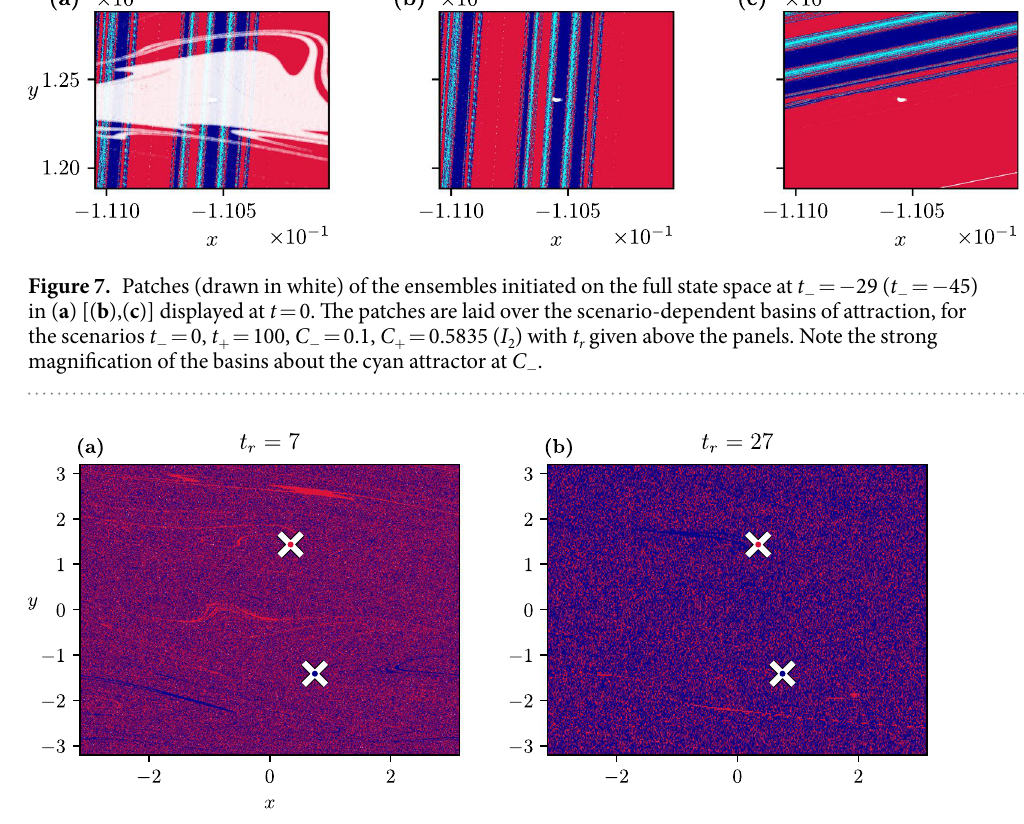
Figure 8. Scenario-dependent basins of attraction for a parameter drift scenario ending at C + = 1.8 (after an extended chaotic regime, interval I 4 in Fig. 1a) with t − = 0, t + = 100. ( a ) C − = 0.1, t r = 7, and ( b ) C − = 0.1, t r =